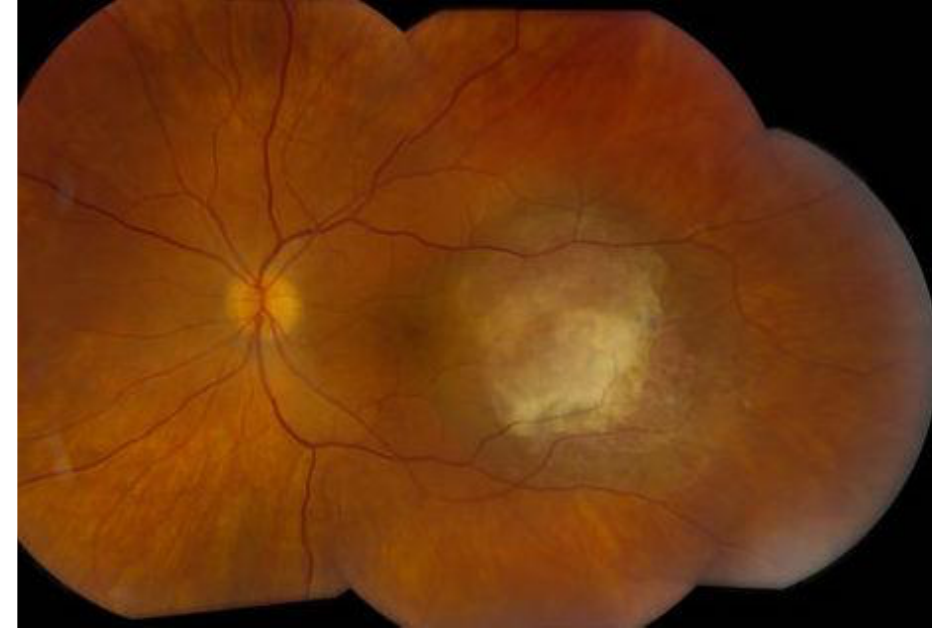
Figure 6. Choroidal haemangiomas.